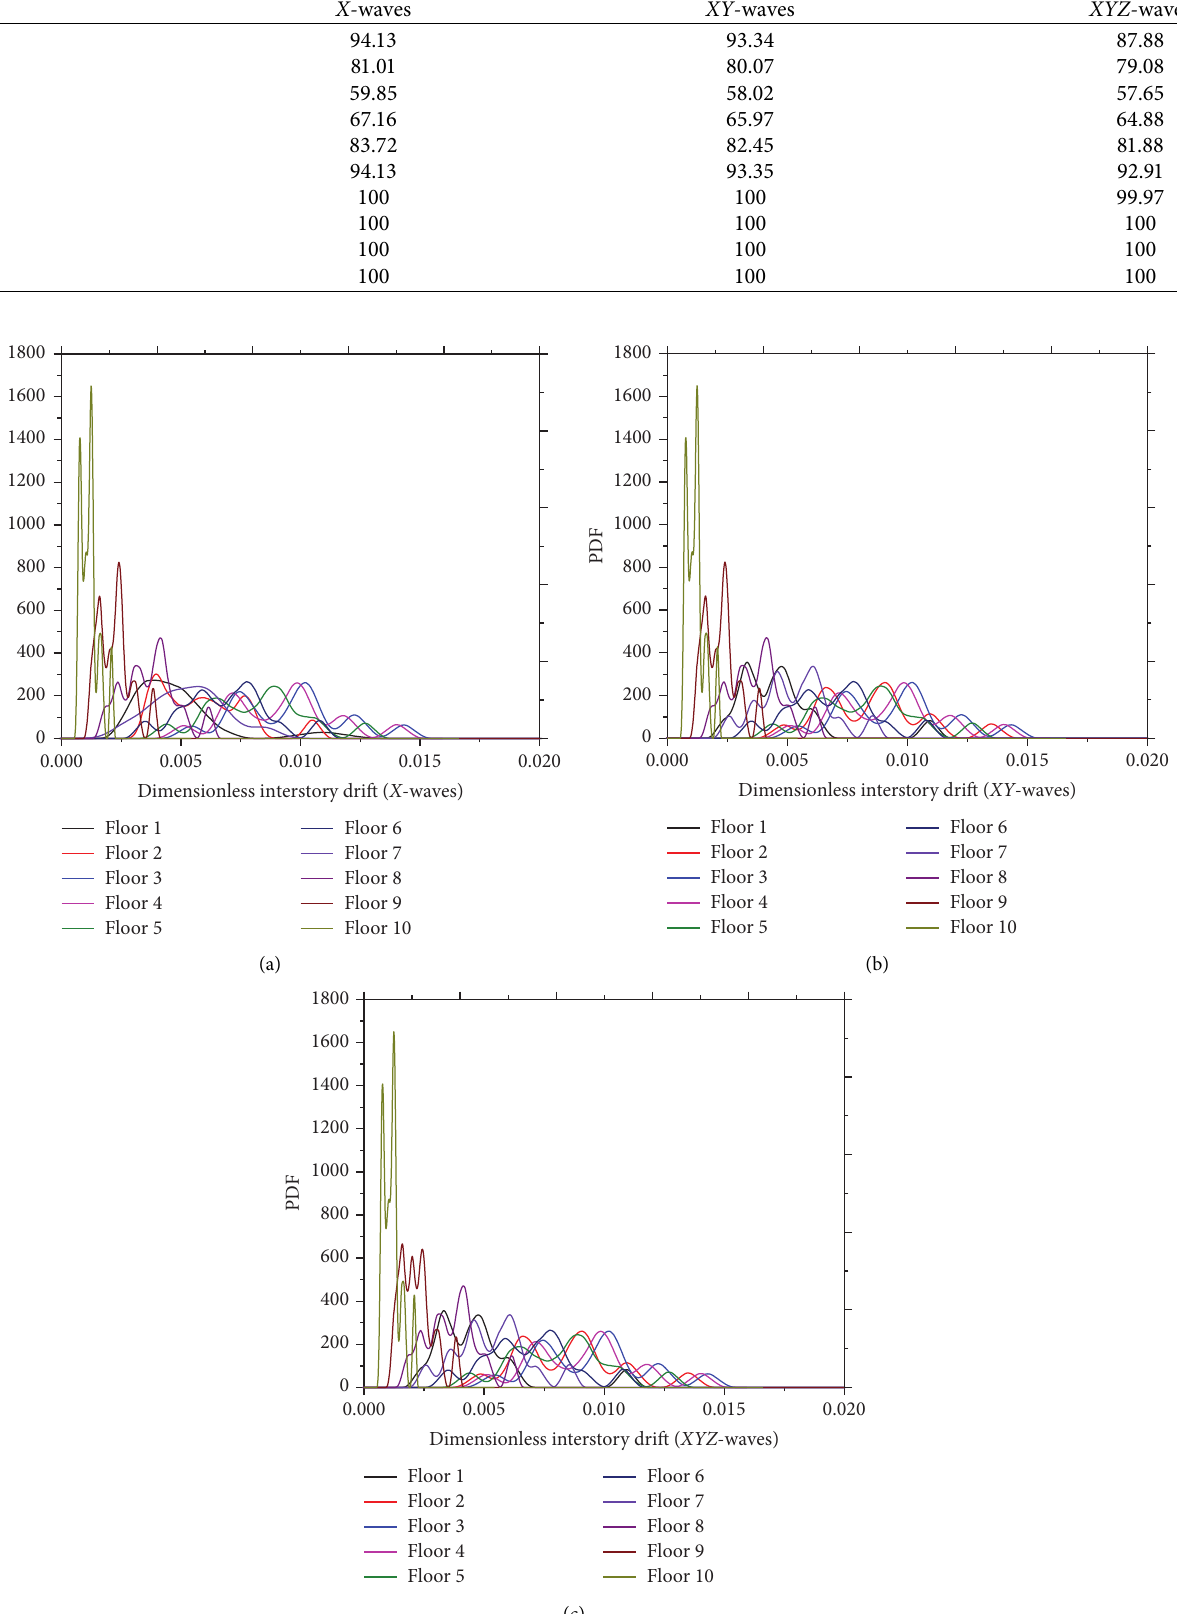
Figure 12: The probability density function of extreme value of the 10-story building. (a) X direction, (b) XY direction, and (c) XYZ